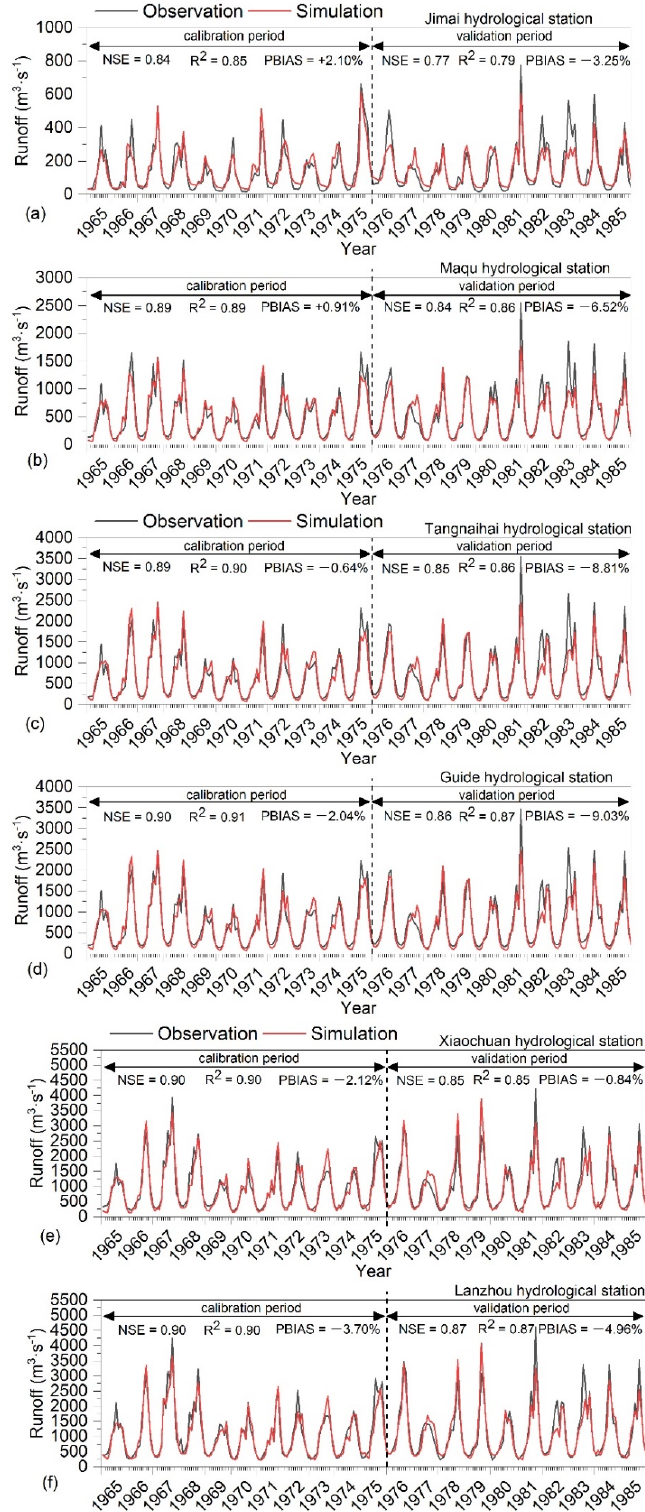
Figure 3. Observed and simulated runoff series during the calibration period (1965 − 1975) and vali- dation period (1976 − 1985) at the hydrological stations in the upper Yellow River Basin. Comparisons of these two runoff series in ( a ) the Jimai, ( b ) Maqu, ( c ) Tangnaihai, ( d ) Guide, ( e ) Xiaochuan and ( f ) Lanzhou hydrological stations,